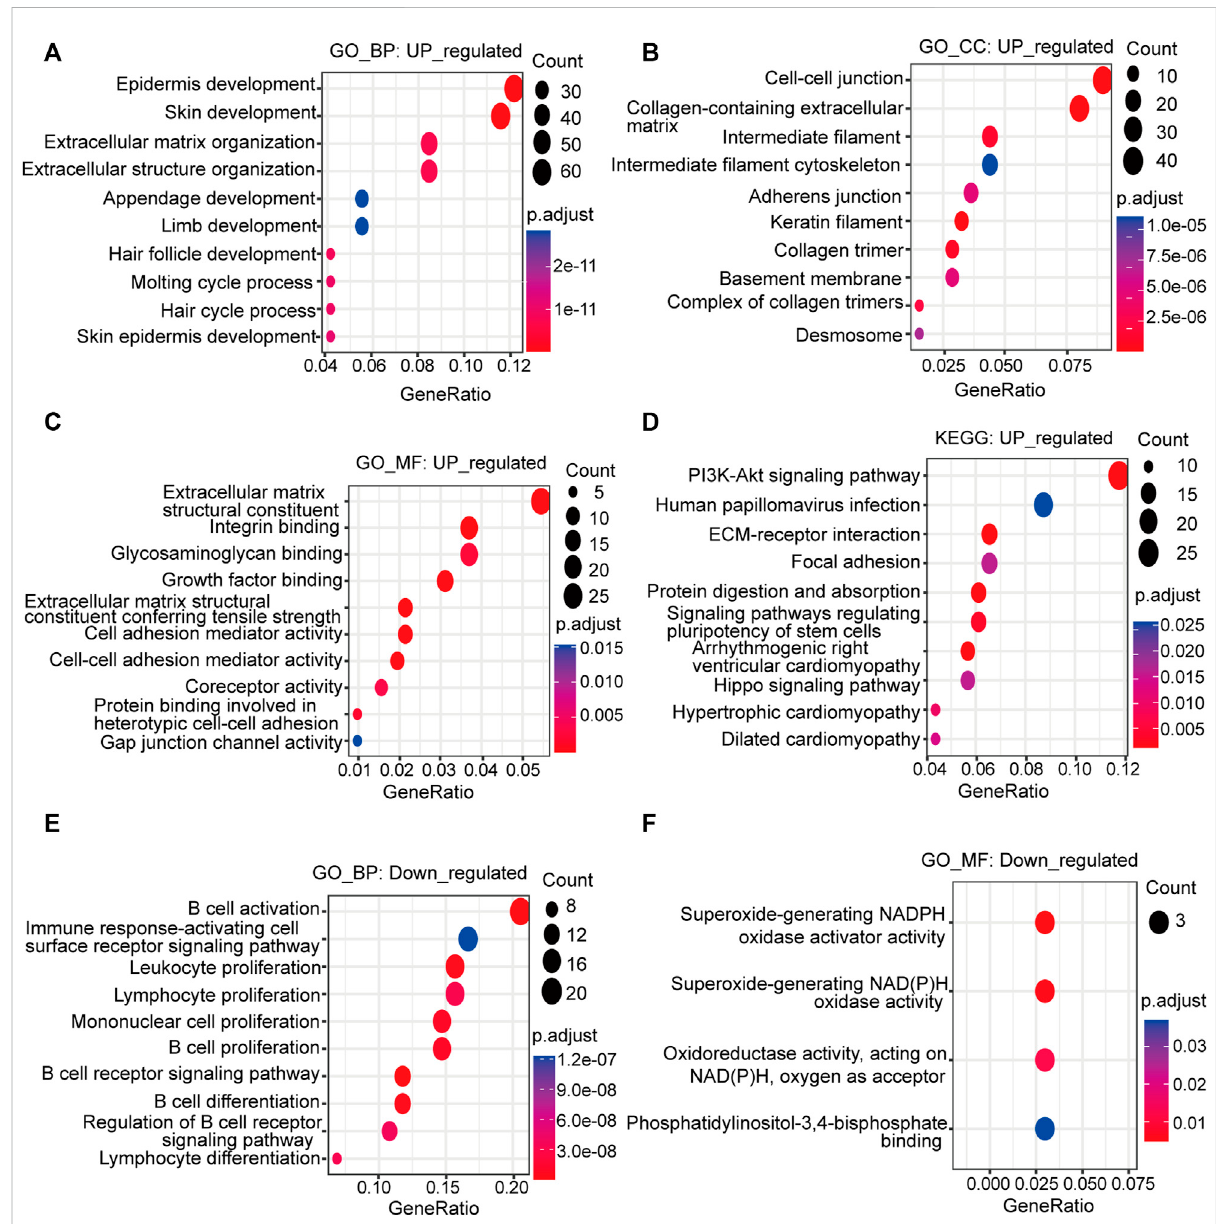
FIGURE 2 Functional analysisoftheupregulated and downregulated DEGs. Bubble plots depict theGOand KEGGsignaling pathway enrichmentanalysis. The size of the bubble represents the gene count, and the color of the dot represents the adjusted p value. Upregulated: (A) BP; (B) CC; (C) MF; (D) KEGG pathway analysis; downregulated: (E) BP; (F) MF; GO: Gene Ontology; KEGG: Kyoto Encyclopedia of Genes and Genomes; BP: biological process; CC: cellular component; MF: molecular